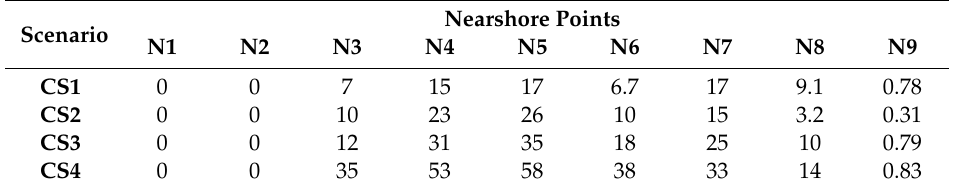
B). The results were compared with the no farm scenario.